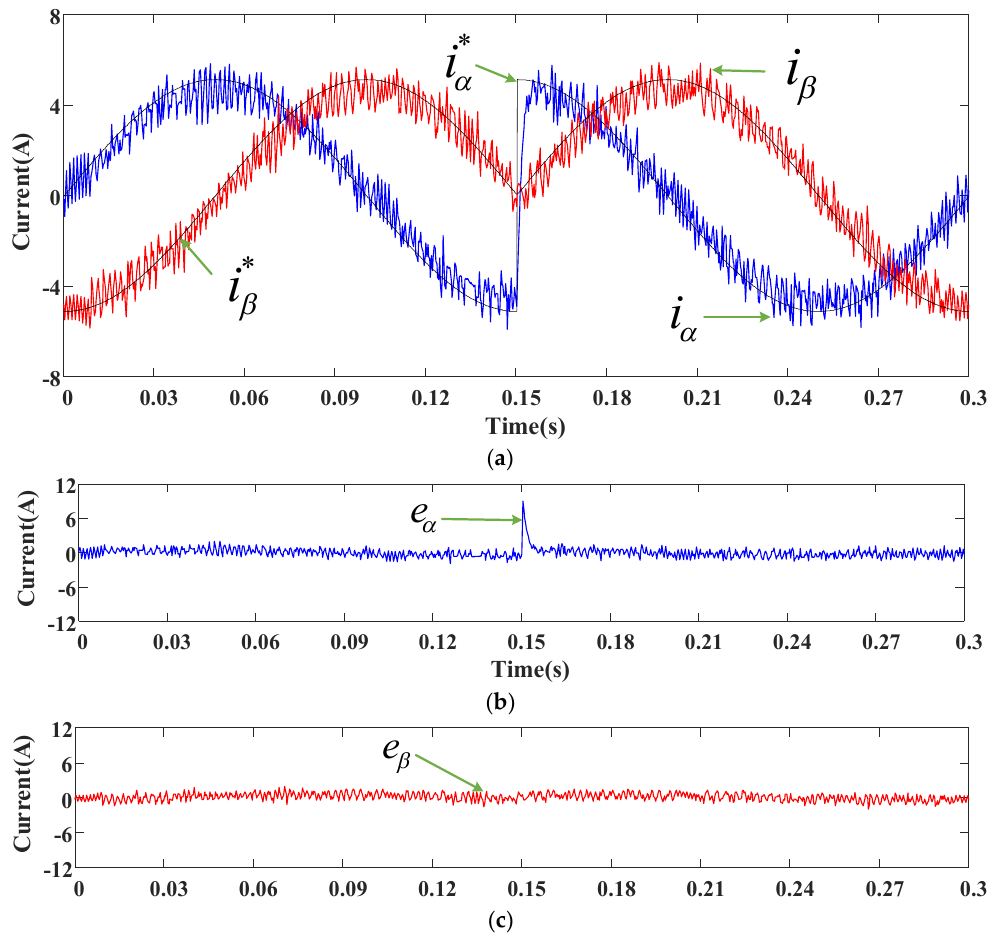
Figure 24. Experimental results of SVV-MPCC following a sinusoidal current command with current reversed at 0.15 s under frequency 10 Hz (case 5): ( a ) current responses; ( b ) α -axis current error; ( c ) β - axis current error.